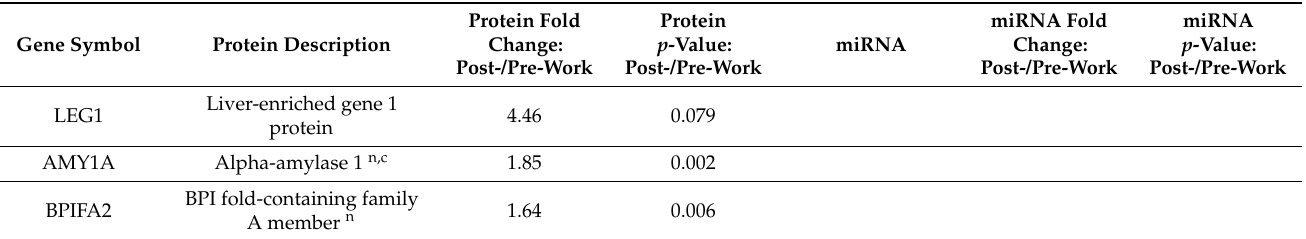
Figure 3. Interconnected protein and miRNA networks regulate molecular pathways associated with increased TMD score in the Discovery group. ( A ) Differences in the abundances of proteins and miRNAs present in the salivary exosomes of Discovery group participants ( n = 20) pre- and post-work shift are illustrated via volcano plot; significant differences are points to the right of the vertical line marked p = 0.05. The log 10 (abundance ratio: post-work/pre-work) is plotted against the − log 10 ( p -value). ( B ) The mean fold change of three significantly altered miRNA (miR-3185, miR-642-5p, miR-134-3p) is shown to inversely relate to the abundances of proteins encoded by one of their target genes (PGK1, PIGR, YWHAZ). ( C ) Gene set enrichment analysis of upregulated and downregulated proteins using Enrichr [23] shows enrichment of KEGG database [24] molecular pathways after a 12 h work shift. Results are ranked according to p value. ( D ) Functional protein association network analysis using STRING [25] shows that associated and interacting protein networks are differentially regulated after a 12 h work shift. Table 1. Identification of differentially abundant proteins and miRNA in salivary exosomes in the Discovery group. The protein–miRNA pairs are listed in the same